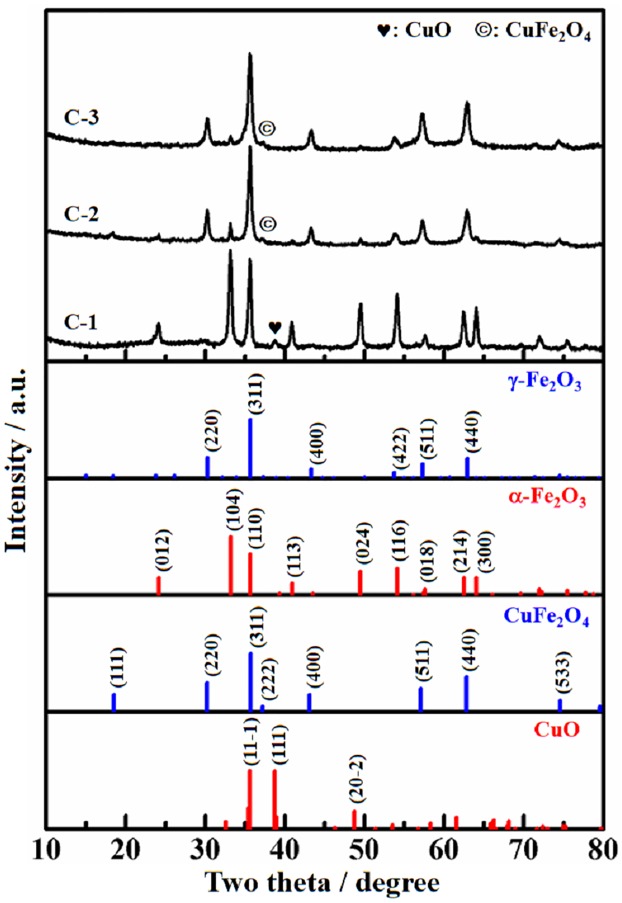
XRD patterns of the catalysts, as well as the standard data for CuO, CuFe2O4, α-Fe2O3 and γ-Fe2O3.